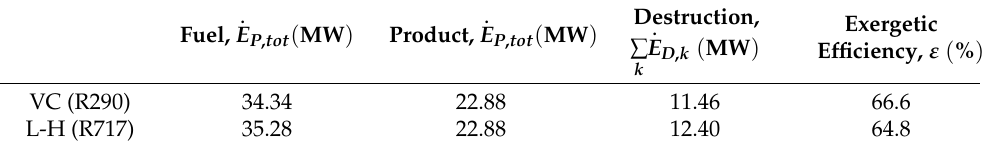
Table 3. The result of exergy analysis of the